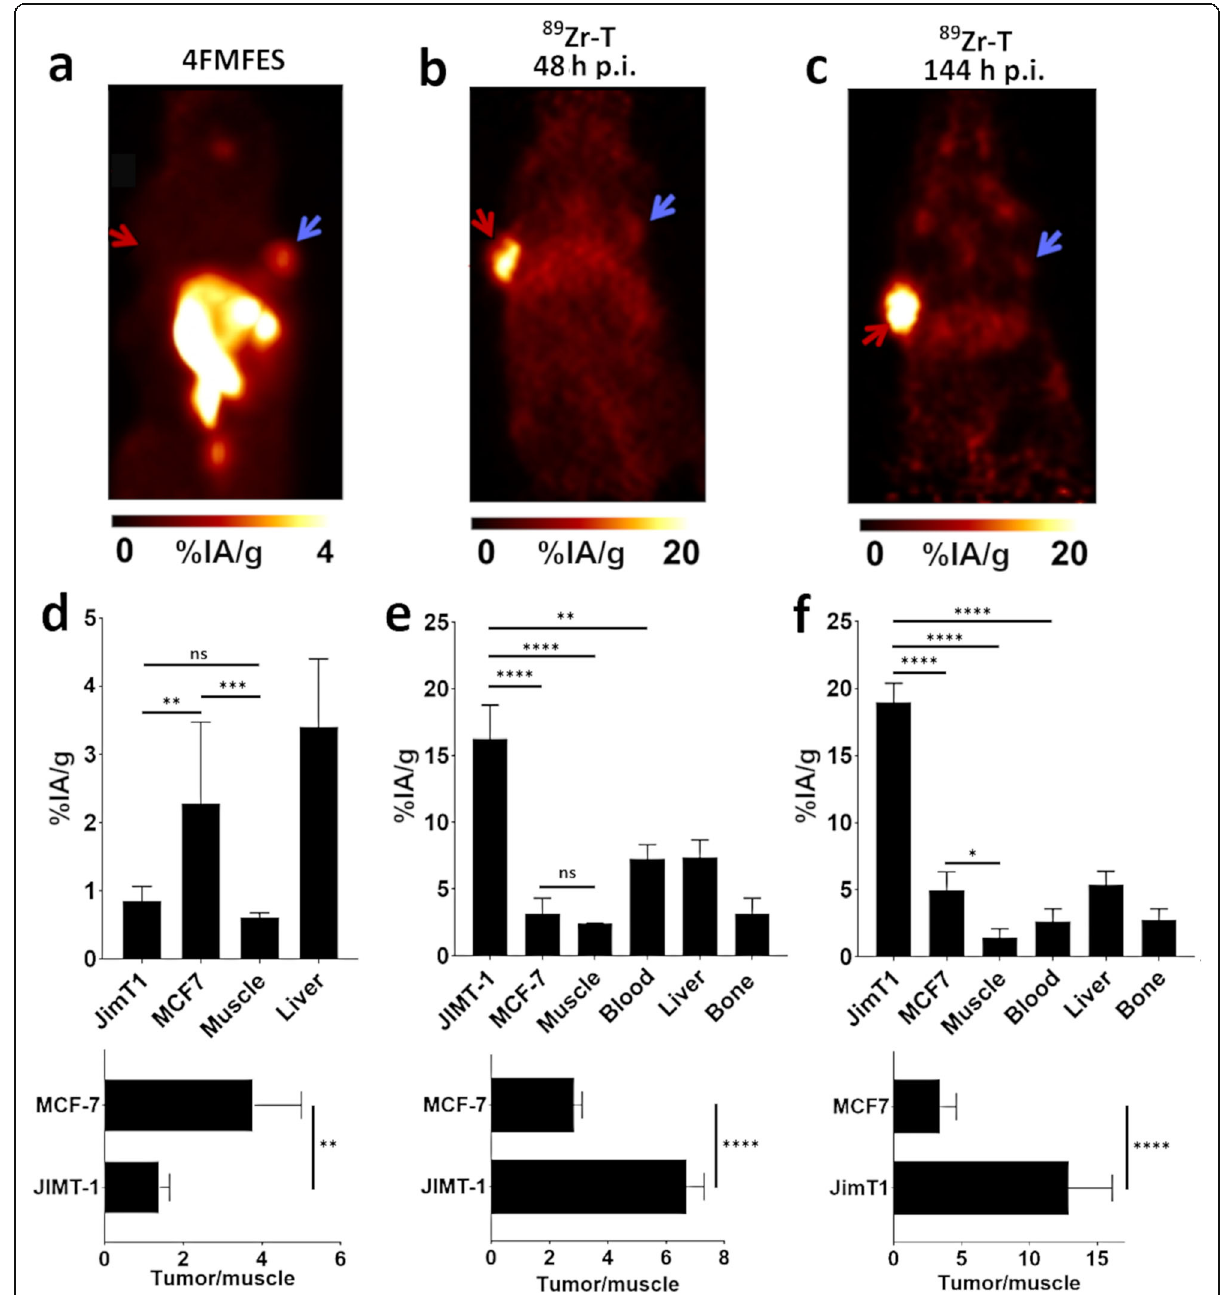
Fig. 3 Sequential 4FMFES and 89 Zr-T PET imaging on mice subcutaneously implanted with MCF-7 and JIMT-1 tumors. MIP image of a representative JIMT-1 (red arrows) and MCF-7 (blue arrows) of a tumor-bearing mice injected with 4FMFES or b with 89 Zr-T and imaged at 48 h p.i. and c at 144 h p.i. PET-derived uptake of relevant organs in %IA/g (upper graphs) and tumor-to-muscle ratios (lower graphs) for d 4FMFES, e 89 Zr-T imaged at 48 h p.i., and f 89 Zr-T imaged at 144 h p.i. showing the phenotype-discerning capacity of the dual-tracer approach. * p < 0.05; ** p < 0.01; *** p < 0.005; **** p <